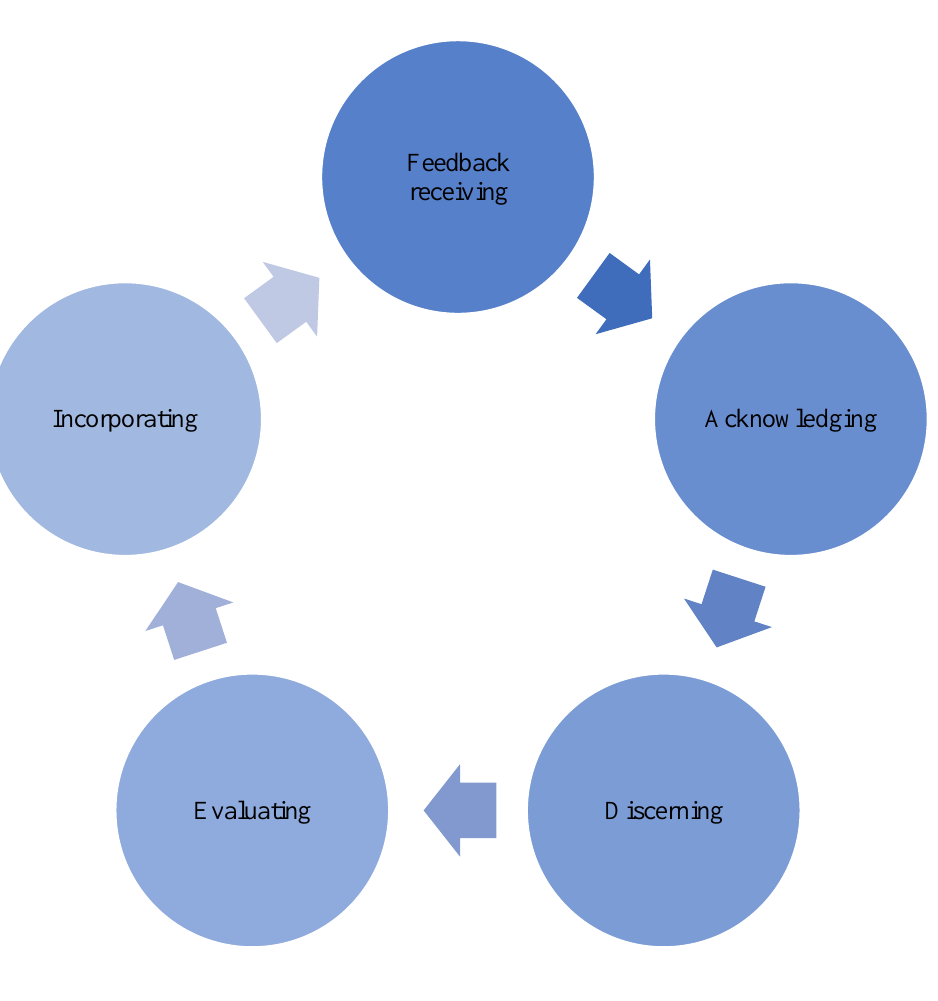
Figure 3: Feedback receiving and elements of the students’ affect. The feedback trajectory of awareness → discernment → acceptance or not → and articulation of rationale for the decision made was part of a system of interdependent components that, when working in tandem, fostered the completion of the reflective project (Zuba Prokopetz, 2019a). Completing the projects is the goal of every student in the final module of this course; however, the realization of how to achieve the end result is what makes the experience meaningful. When sufficient time is provided, students choose to engage and interact with each other and their eportfolios. Engagement with the project and